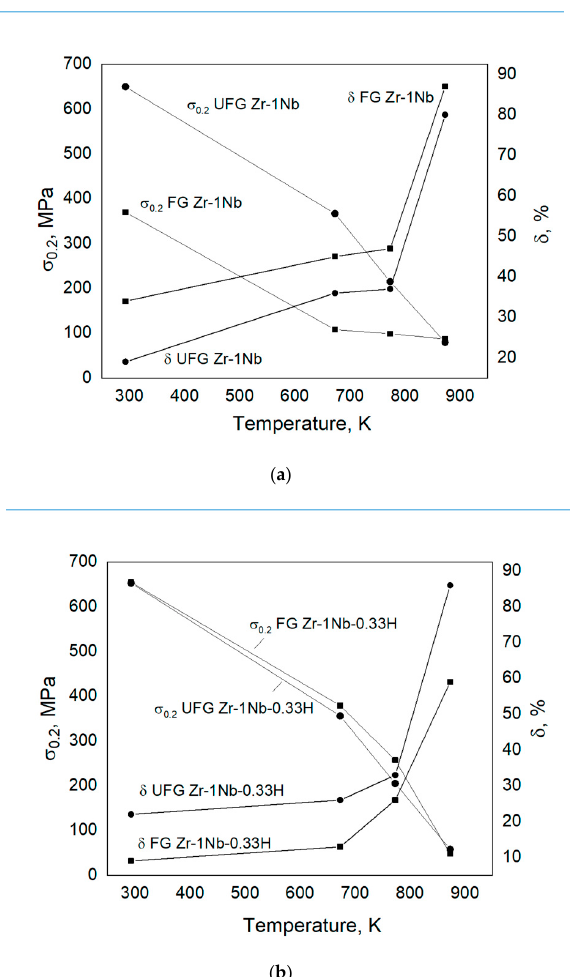
Figure 10. Dependences of the yield strength ( σ 0.2 ) and the deformation to failure ( δ ) on the test temperature for the ( a ) Zr–1Nb and ( b ) Zr–1Nb–0.33H alloys in the FG and UFG